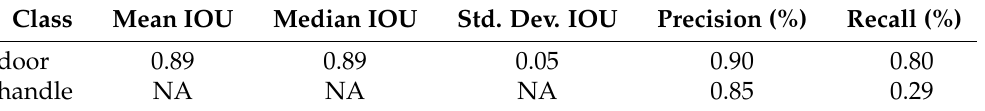
Table 1. Evaluation of the object detection.